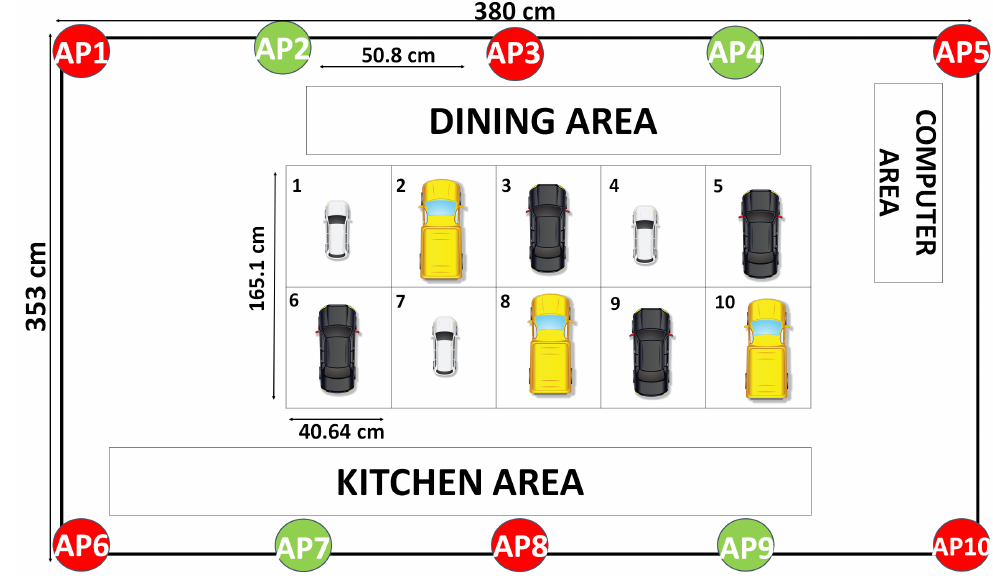
Figure 3. Second testing site with obstacles provided by the computer and kitchen areas and has 10 available parking